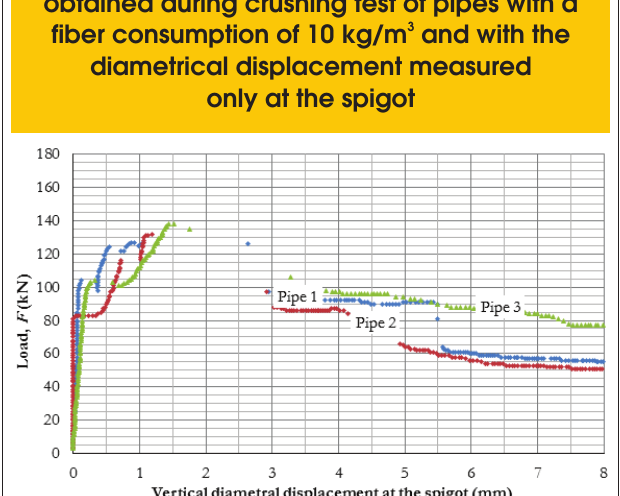
obtained during crushing test of pipes with a 3 fiber consumption of 10 kg/m and with the diametrical displacement measured only at the